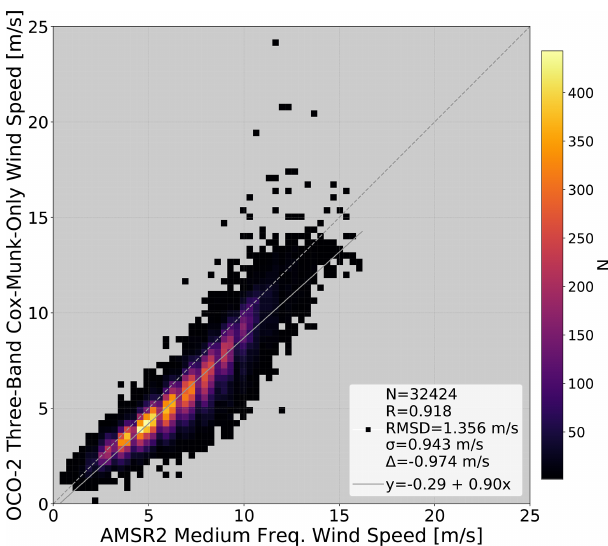
Figure 3. Heatmap of OCO-2 O 2 A-band signal compared to wind speed difference (OCO-2 TSIS solar – AMSR2 medium frequency).